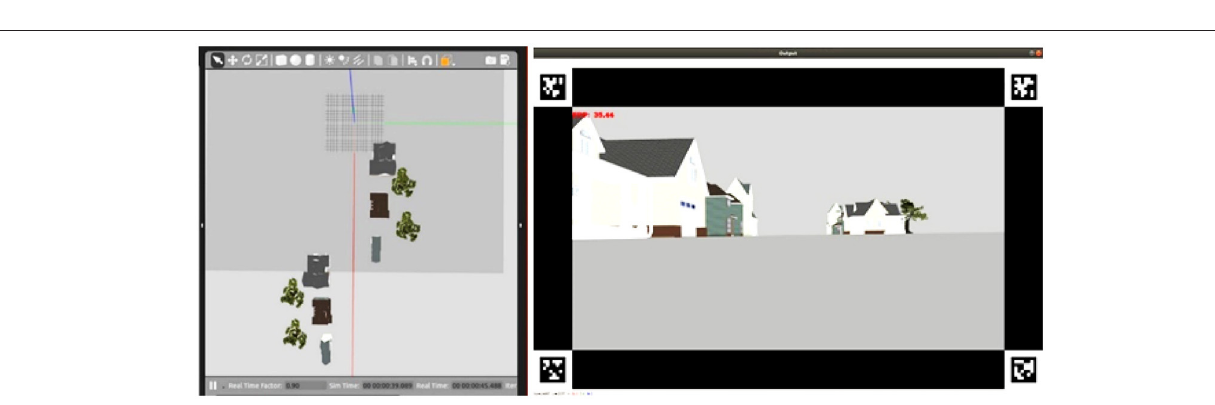
FIGURE 7 | Exploration task. Left : top view of the simulated environment used in the test allowing the experimenters to visualize the whole set-up off-line. Right : first-person view seen by the user.